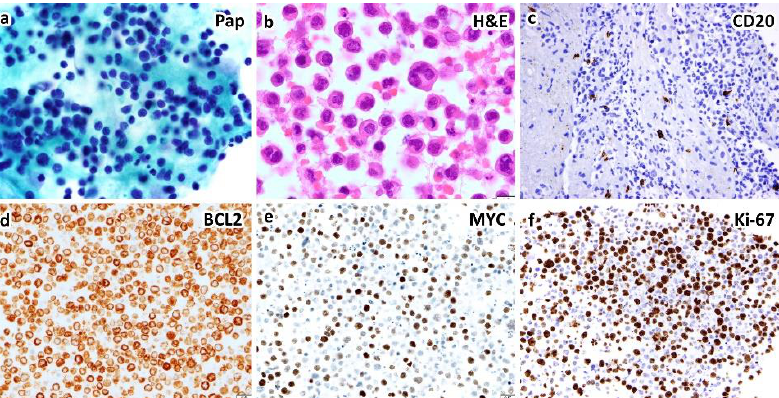
Figure 3. An example of HHV8-negative type II PEL (or effusion-based lymphoma) of indeterminate (B-cell vs. plasmablastic) phenotype in a 59-year-old woman presenting with pleural effusion without hepatosplenomegaly or lymphadenopathy by CT scans. Cytological smears show large, atypical lymphocytes by Papanicolaou stain ( a ). Cell block section shows anaplastic cells and occasional Hodgkin/Reed–Sternberg-like cells (( b ), H&E stain). Immunohistochemically, the atypical lymphocytes express BCL2 ( d ), BCL6, IRF4/MUM1 and MYC ( e ), but not CD3, CD10, CD20 ( c ), CD30, CD138, cyclin D1, or HHV8-LANA1. Ki-67 proliferation index is up to 70% ( f ). EBER in situ hybridization is negative (( a , b ), ×1000; ( c – f ), ×400 magnification). Classic PEL shows a plasmablastic phenotype with neoplastic cells express activa- tion and plasma cell-related markers such as CD30, CD38, VS38c, CD138, and IRF4/MUM1 and usually lack pan-B markers such as CD19, CD20, CD79a, and Pax-5 (Figure 1 and Table 2). Expression of CD45/LCA and epithelial membrane antigen (EMA) is commonly seen [9,24,44,45]. The tumor cells are positive for HHV8-associated protein LANA-1 (typically nuclear and granular), which is useful for the diagnosis of PEL [24,44,45,92]. Surface and cytoplasmic Ig is absent, in contrast to the cytoplasmic IgM lambda expression by the tumor cells of HHV8-positive DLBCL, NOS [45,91]. In situ hybridization for EBV-encoded mRNA (EBER) was positive in about 65 – 80% PEL cases [8,62]. EBV-LMP1 is variable with absent or low expression in PEL, indicating a re- stricted latency pattern of EBV infection [91,92]. Rare cases of HHV8-positive lymphoma with features similar to PEL can present as tumor masses and are considered to represent an extracavitary or solid variant of PEL. Compared with classic PEL, the extracavitary or solid variant of PEL had a significantly lower expression rate of CD45, but more frequent expression of CD20, CD79a, and CD138 [93]. It is important to distinguish HHV8-negative PEL from classic PEL because these two appear to differ in pathogenesis, morphological and immunophenotypic character- istics, clinical behavior, and prognosis [12]. Table 2 lists the pertinent clinicopathological features between classic (type I) and HHV8-negative (type II) PEL. The majority of tu- mor cells in HHV8-negative PEL express pan B-cell markers and do not express activa- tion marker or plasma cell-associated antigen (Figure 2 and Table 2). Our literature re- view revealed that EBV infection was less common in HHV8-negative PEL (21.0%; 30/143) than in classic HHV8-poisitive PEL (65 – 80%).